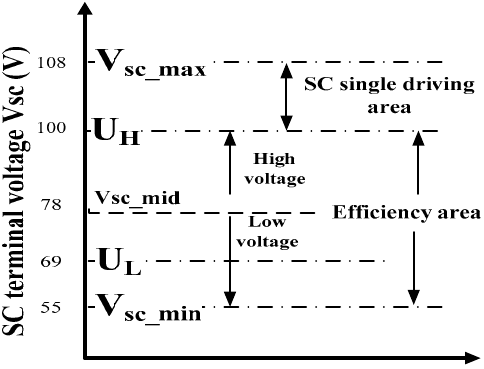
Figure 4. Division of the SC working states. 161